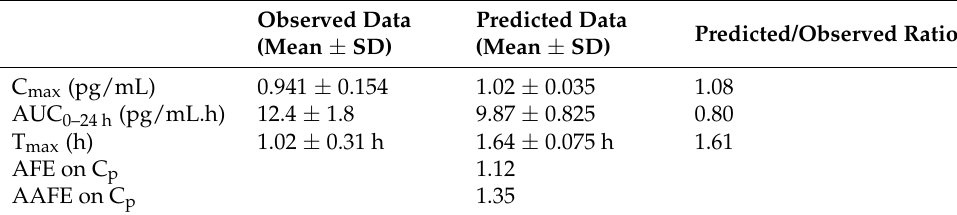
Table 5. Overview of the mean observed data from Jubert et al. (2009) [28] and the simulated data in the Sim-Chinese healthy volunteer population. The prediction/observed ratio is given in the right column.